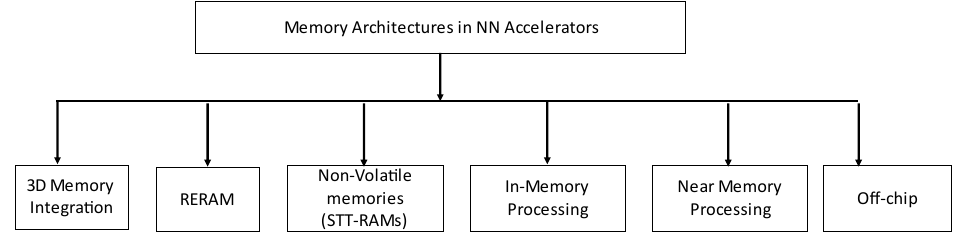
Figure 1. Classification of the memory architectures discussed in this survey.